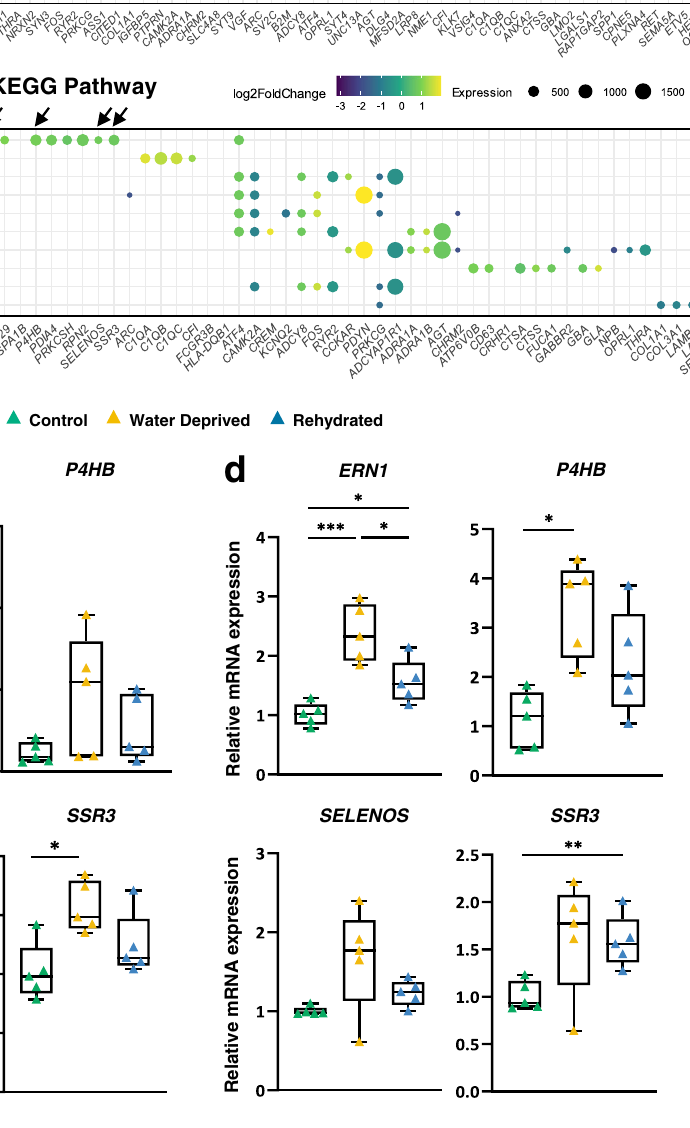
analysis. 21 terms for GO: BP (Fig. 6a) and 10 terms for KEGG pathways (Fig. 6b) were identi fi ed to be overrepresented with DEGs regulated by WD (padj ≤ 0.05) using over-representation analysis (Supplementary Data S4a). Amongst the enriched GO: BP terms, 7 terms were related to synapse, 4 were related to neurotransmitter secretion (Fig. 6a). “ Modulation of chemical synaptic transmission ” (padj = 0.0062) and “ Regulation of